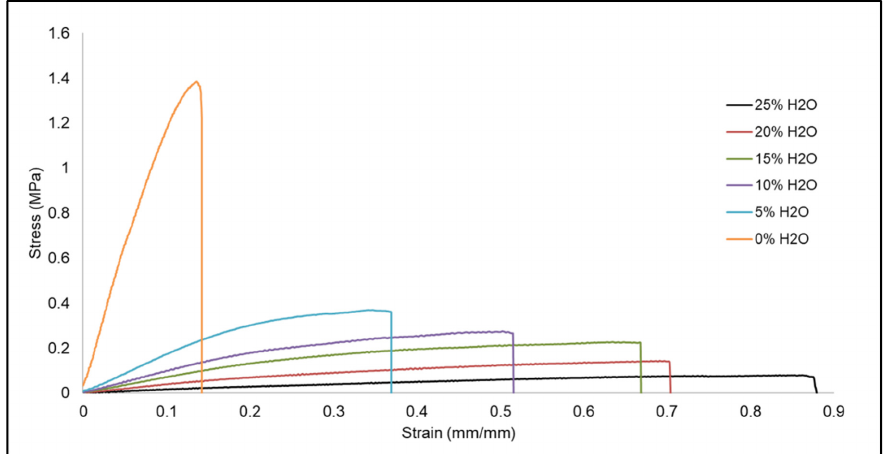
Figure 5. Relative stress (MPa) versus strain (mm/mm), for tensile testing, of SMP foams with varying water content.